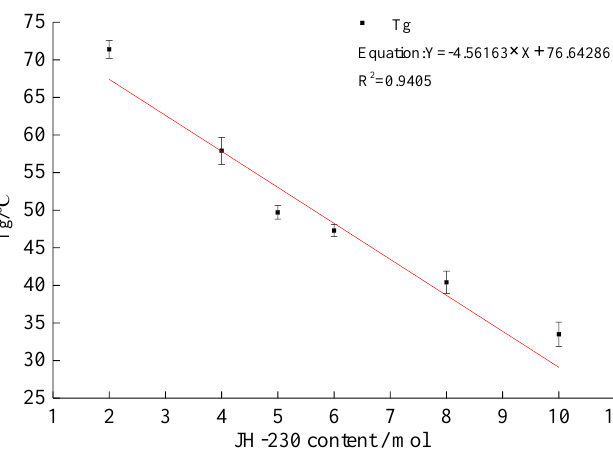
Figure 4. The linear fit of the JH-230 content and T g .